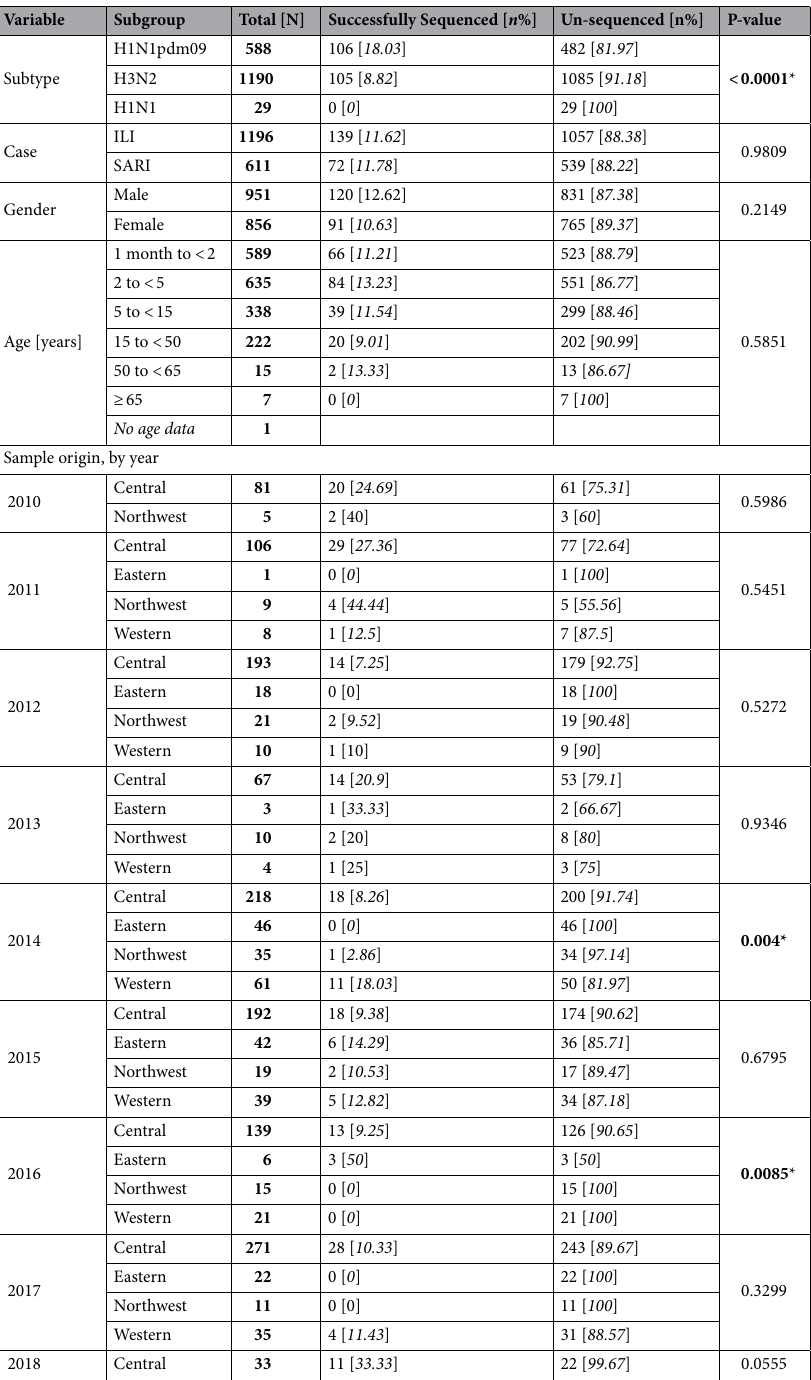
Table 1. Comparison of demographic characteristics of influenza A positive patients sampled by the general UVRI-NIC surveillance programme whose viral swabs were successfully or not sequenced. Initially, there were 1800 positives for a single influenza A subtype (H1, H1N1pdm09 and H3N2) in the UVRI-NIC dataset. After excluding one duplicated H1N1pdm09 viral sample (ARU0583), there remained 1799 positive A samples. We included 8 successfully sequenced samples that tested and were reported as positive in the laboratory dataset (used for sample randomization) but were reported as negative in the UVRI-NIC dataset. Therefore, the demographic characteristics presented in this table were for 1807 patients recorded in the UVRI-NIC dataset. 234 of the 1807 patient’s viral swabs were sampled for whole genome sequencing, and 215 of the 234 were successfully sequenced. However, four sequenced viruses (ARU0587, EBB2521, KIB0497, and KSW0631) lacked complete demographic data so we present data for only the 211 viruses that were successfully sequenced with complete data. Percentage number of sequenced or un-sequenced swabs are in [italics]. P-values showing significant differences between compared groups (< 0.05) are indicated in bold with a star